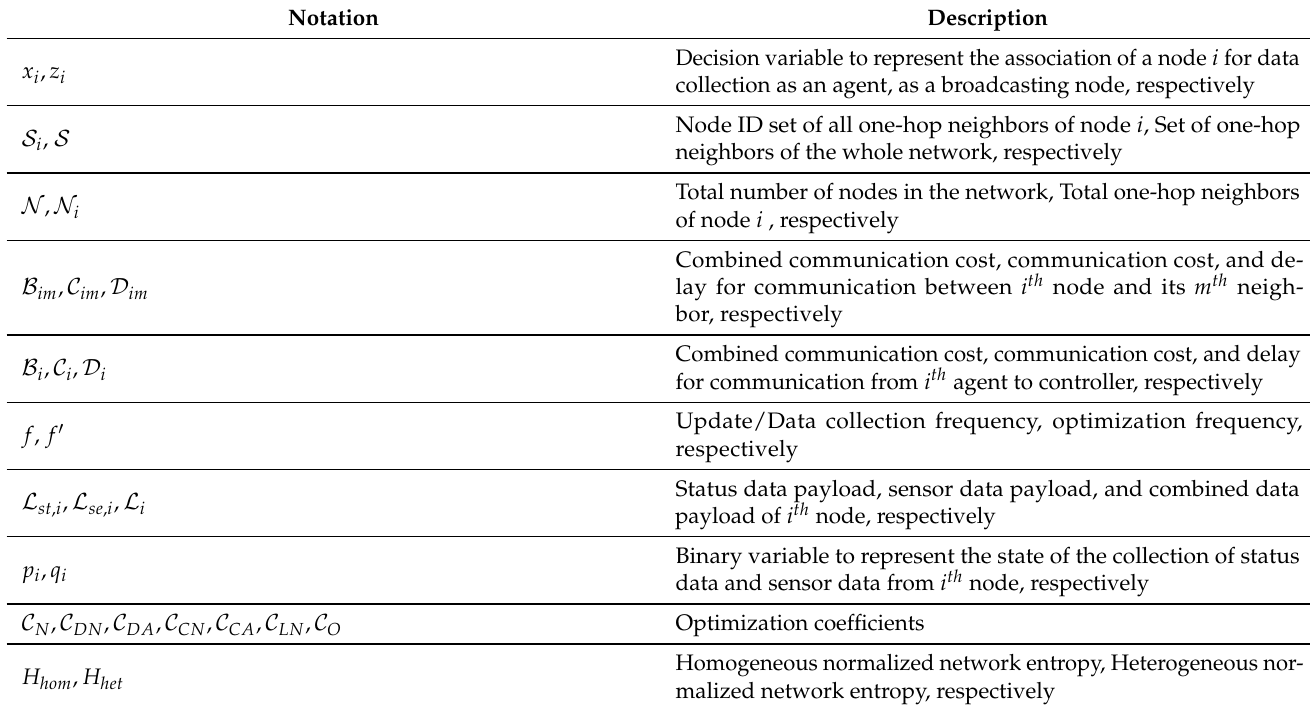
Table 1. Summary of notations used in the proposed data collection optimization